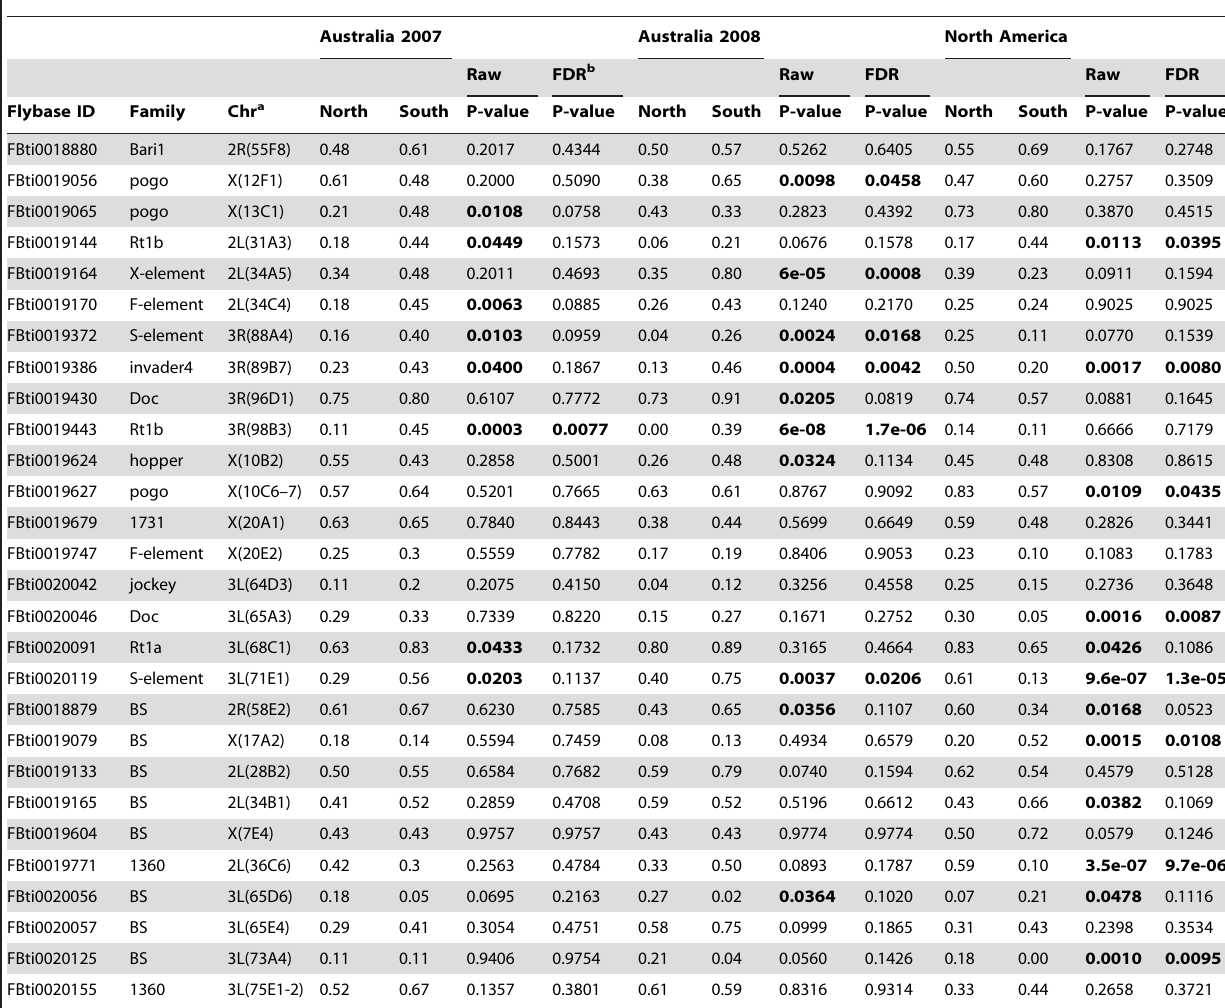
Table 1. Population frequencies of the 28 TEs analyzed in this